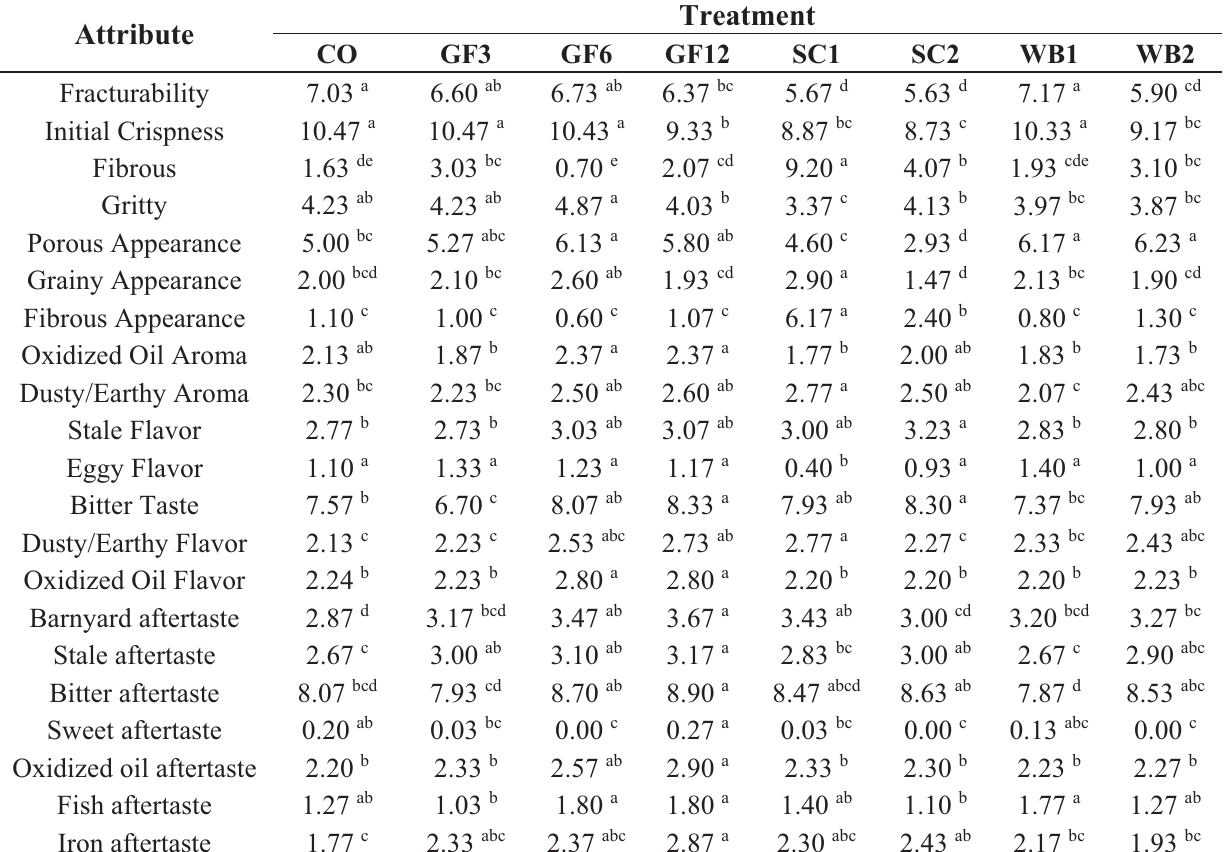
Table 2. Average texture, appearance, aroma, flavor, and aftertaste attributes intensity scores for uncoated treatments. Significantly different attributes showed only ( p <